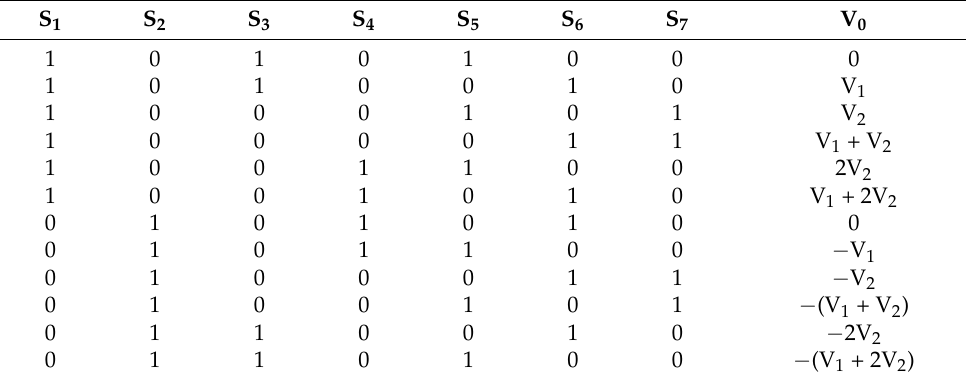
Figure 1. Structure of proposed multilevel inverter topology. Table 1. Switching states for the proposed topology.